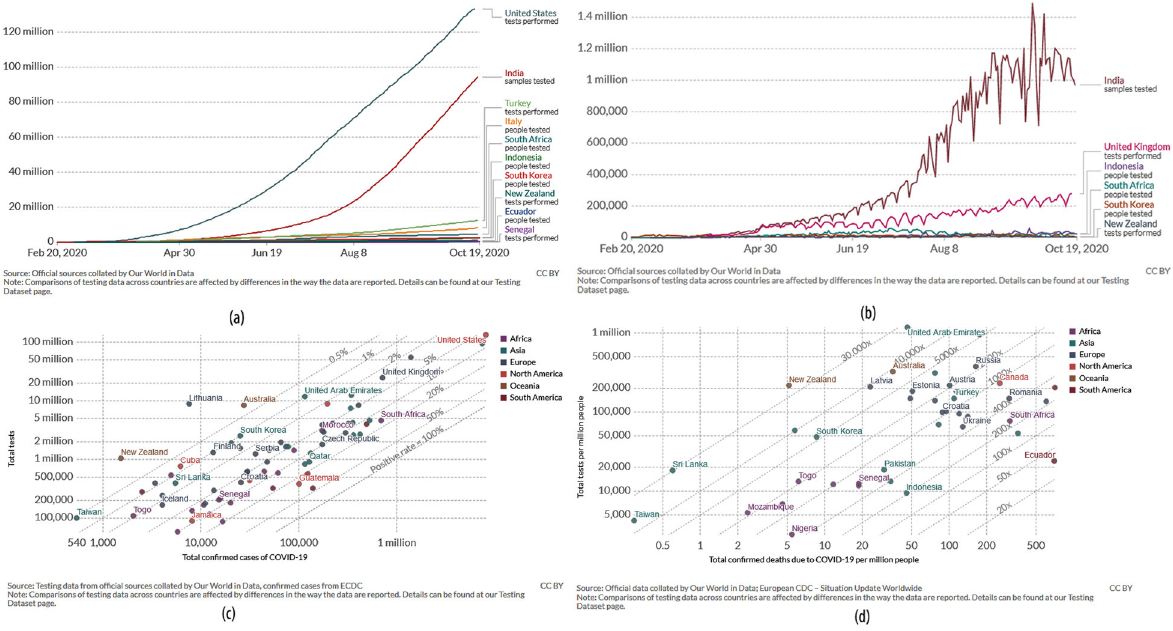
Fig. 4 During the severity of COVID19, the reposnse of government agencies with monitoring and testing to generate factual data for continues upgradation in action plans. Graph showing ( a ) total number of COVID19 tests conducted ( b ) Daily COVID19 tests conducted (country Wise) ( c ) Tests conducted vs. con fi rmed cases ( d ). Tests conducted vs. con fi rmed deaths till 19 October 2020. This fi gure is covered by the Creative Commons Attribution 4.0 International License as mentioned on Source: https://ourworldindata.org/coronavirus-data.